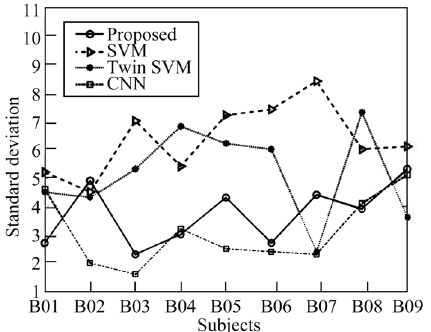
Figure 11. Standard deviation comparison with four methods